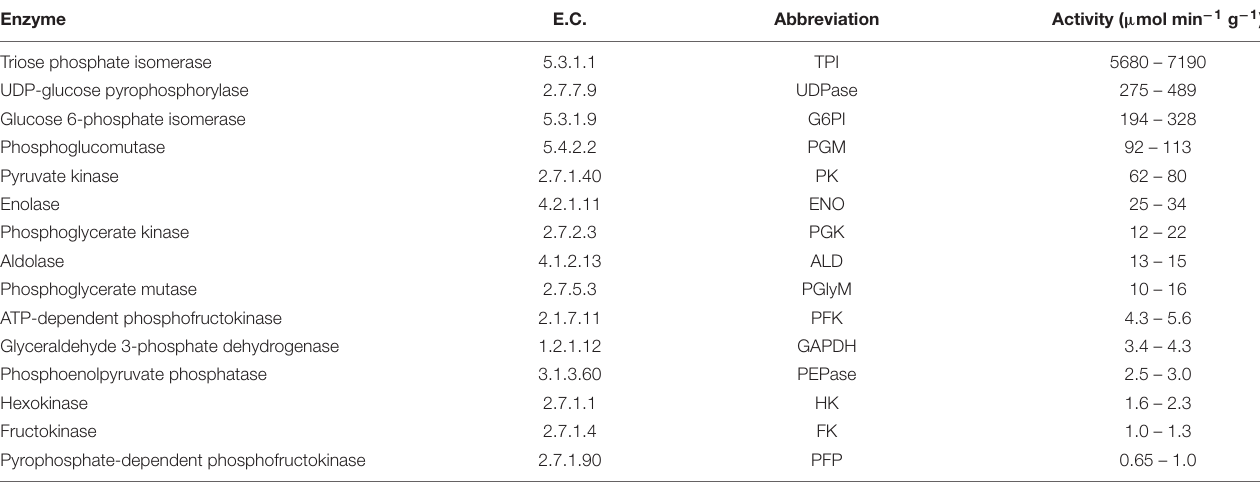
TABLE 1 | Enzyme Commission (E.C.) numbers, abbreviations used, and the range of activities for glycolytic enzymes that were characterized in sugarbeet roots during 60 days storage. Enzyme